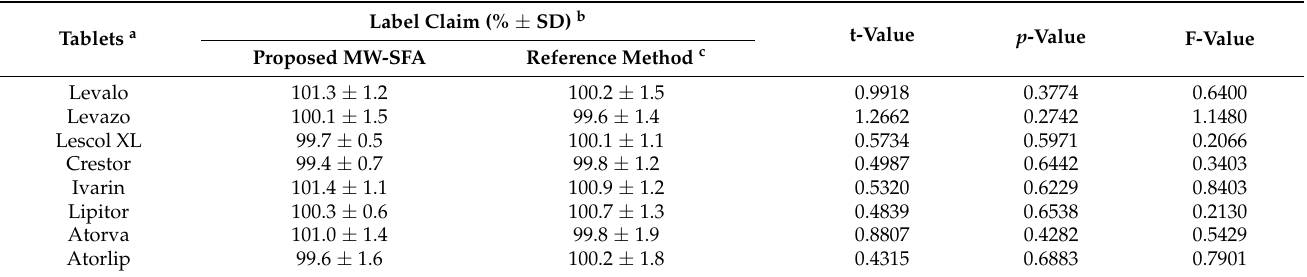
Table 5. Analysis of statin-containing tablets and statistical comparison between the accuracy and precision of the proposed MW-SFA with the reference